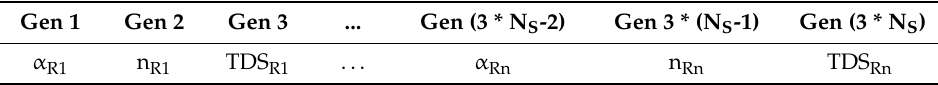
Table 2. GA chromosome